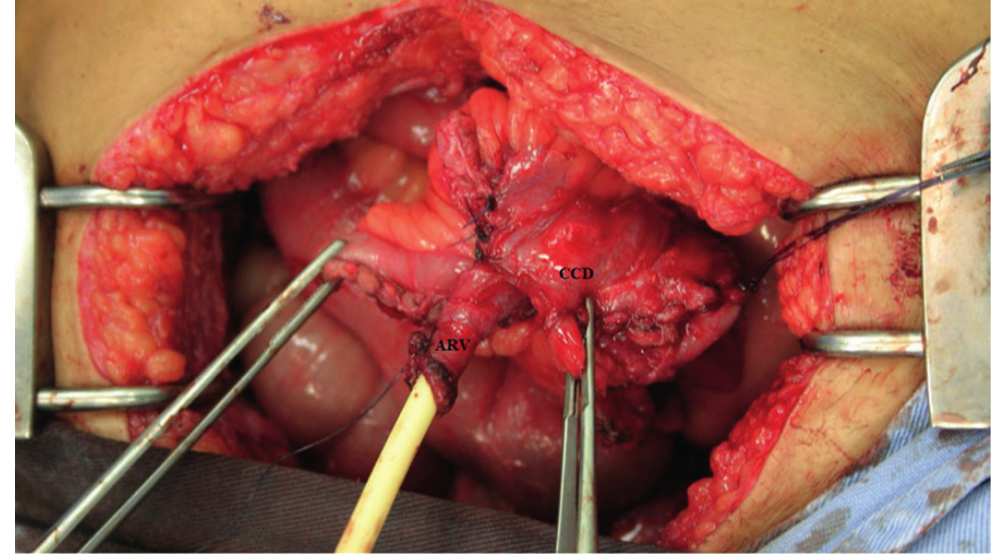
figure 4 - continent cutaneous urinary diversion (ccD) and anti-reflux valve